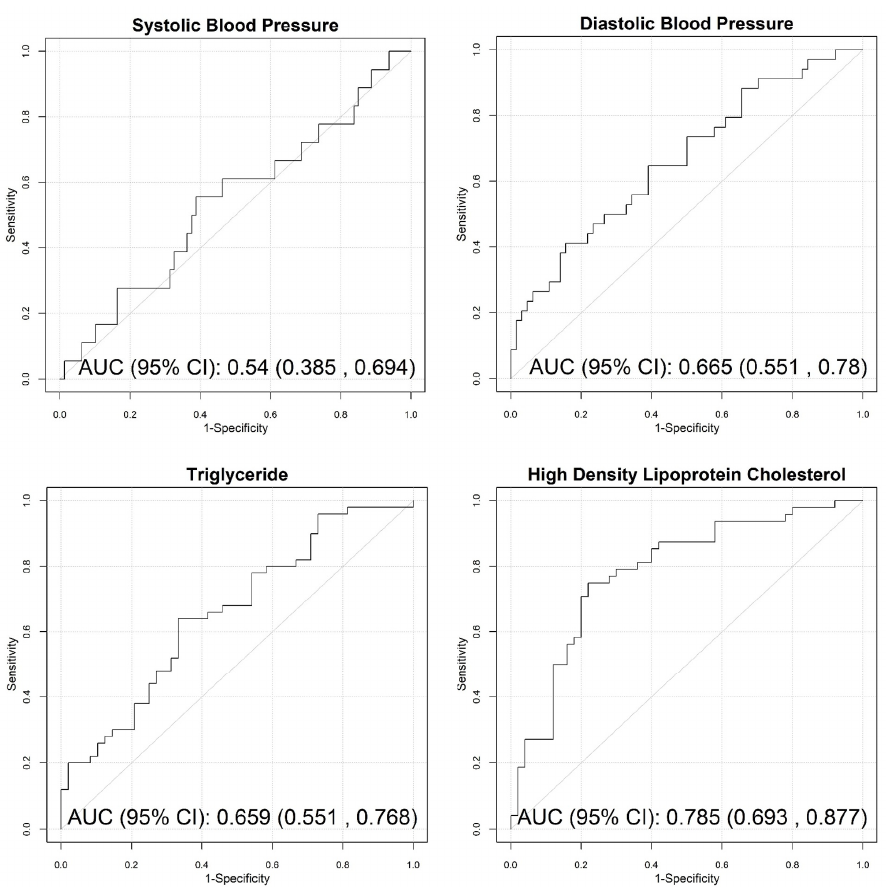
Figure 2. Prediction results of for efficacy models of four metabolic risk factors.